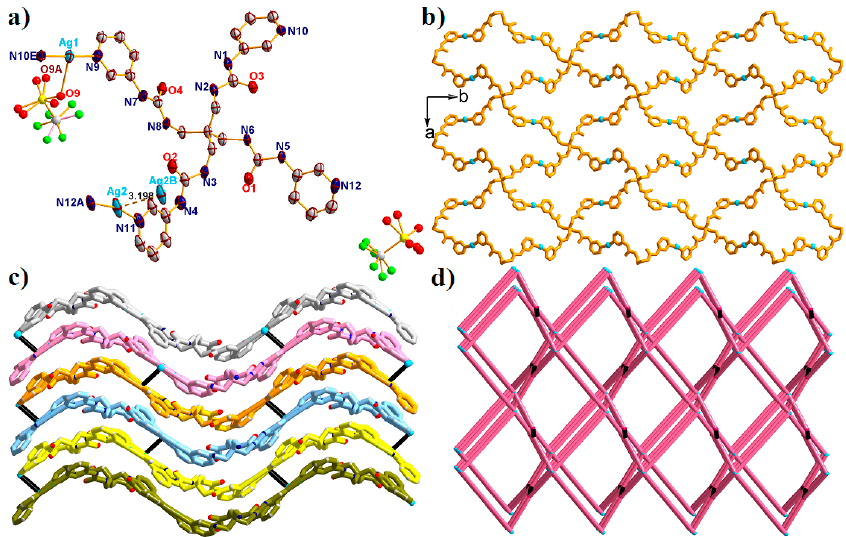
Figure 2. ( a ) The asymmetric unit of complex 1 with 50% probability ellipsoids. All the solvents and hydrogen atoms have been omitted for clarify. (Symmetry codes: A: 1 − x , − 1/2 + y , 3/2 − z ; B: 1 − x , − 1 − y , 2 − z ; E: − x , − 1/2 + y , 1/2 − z ). ( b ) The 2D [Ag 2 (L)] n layer of 1 view along c direction. ( c ) The Ag ··· Ag interactions expanded 3D framework of 1 . ( d ) The simplified 3D (3,4)–connected